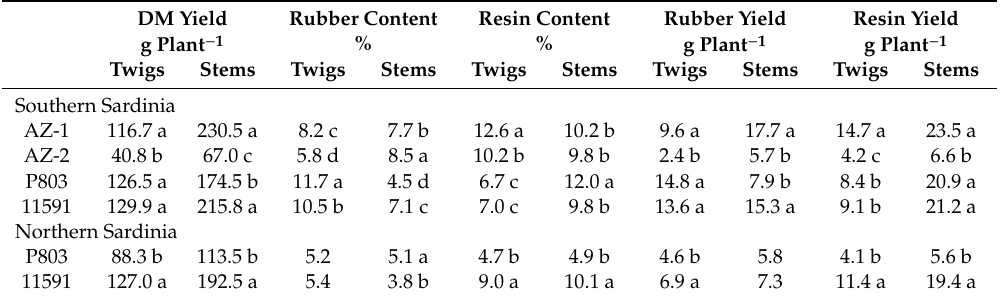
Table 7. Aboveground biomass fractions, rubber and resin content and yields of plants at 30-month growth at the two sites. DM Yield Rubber Content Resin Content Rubber Yield Resin Yield g Plant − 1 % % g Plant − 1 g Plant − 1 Twigs Stems Twigs Stems Twigs Stems Twigs Stems Twigs Stems